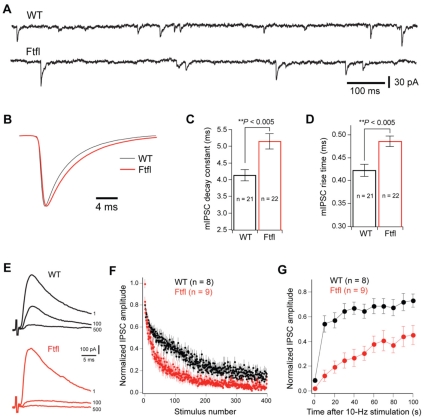
Altered GABAergic transmission in cortical neurons of fitful mice.(A) Samples of GABAergic mIPSCs recorded from a wildtype (upper trace) and a fitful (lower trace) layer V pyramidal neuron at P14 in the presence of DNQX, kynurenic acid, and TTX. The patch pipettes contained 130 mM KCl, and holding potential was at −70 mV. (B) Averaged mIPSCs from 21 wildtype cells (grey) and 22 fitful cells (red) with normalized peaks. (C,D) Histograms of the decay constant (C) and rise time (D) of mIPSCs for wildtype and fitful cells. The mean decay time constant was 5.2±0.2 ms (n = 22) for mutant cells, and 4.1±0.2 ms (n = 21) for wildtype (p<0.005, Mann-Whitney test). (E) Samples of evoked GABAergic IPSCs in response to 10-Hz stimulation recorded from a wildtype (upper black traces) and a fitful (lower red traces) cell at P14 in the presence of DNQX and kynurenic acid. For both cells, the three traces were responses to the first, 100th, and 500th stimulus. The patch pipettes contained 110 mM cesium methylsulfate, and holding potential was at 0 mV. A pair of twisted microwire was placed in layer V to evoke monosynaptic IPSCs. (F) Plots of evoked IPSCs in response to 400 stimuli at 10 Hz. For each cell, peak amplitudes of IPSCs were normalized to that of the baseline response. (G) Recovery after 1000 stimuli at 10 Hz. IPSCs were measured every 10 s after the 10-Hz stimulation. Peak amplitudes of IPSCs were normalized to that of the baseline response before the 10-Hz train stimulation.